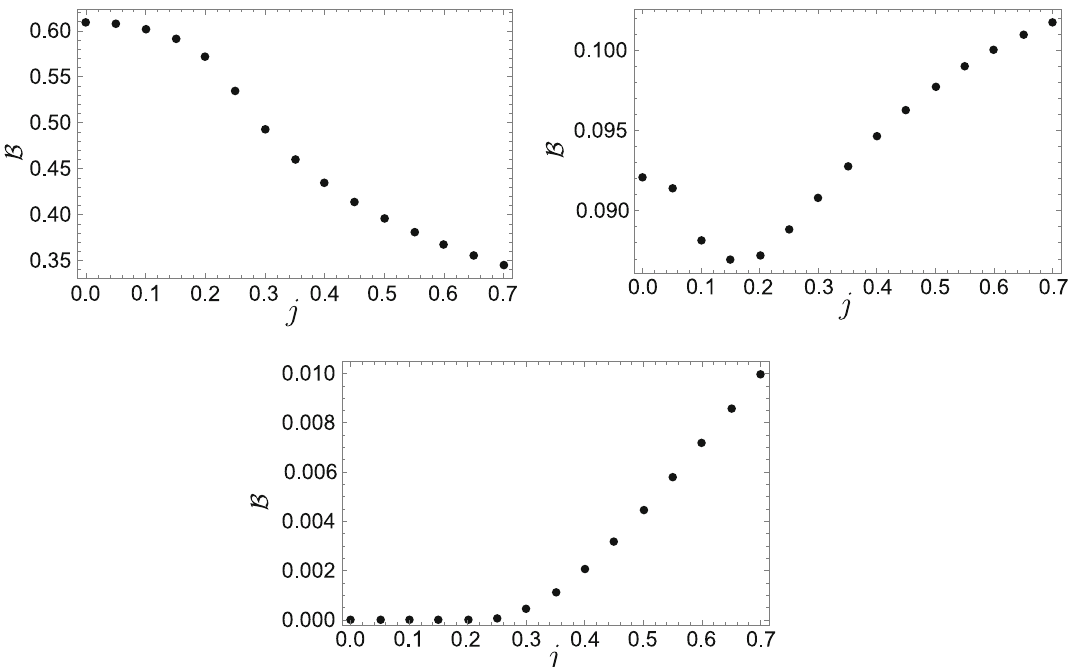
Fig. 17 The global trapping efficiency coefficient B for R / M = 2 . 4 is shown in the top left panel, with that for R / M = 2 . 8 in the top right panel and that for R / M = 3 . 2 in the panel